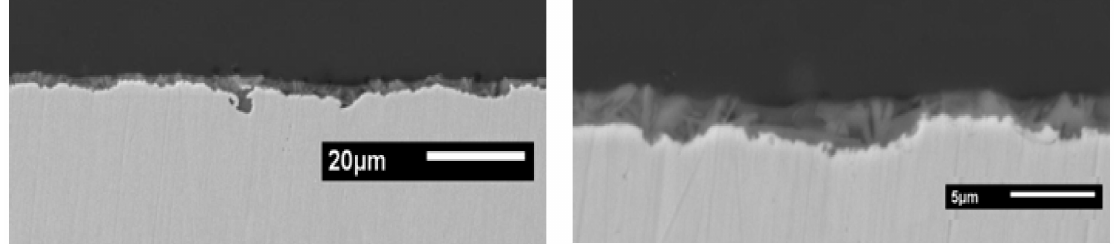
Figure 11. Scanning electron micrographs of cross-section of TEOS/(50%MAP + 50%UPS) coating deposited on phosphated